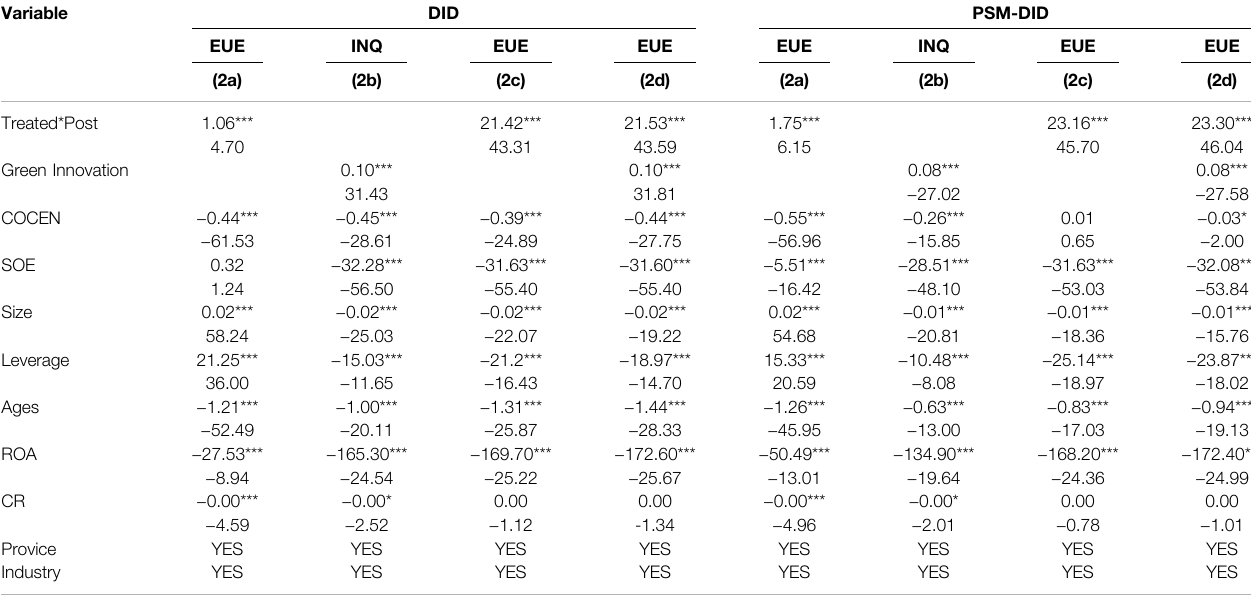
TABLE 14 | OLS robust standard error regression results about regulation by changing the size with Enterprise income. Variable DID PSM-DID EUE INQ EUE EUE EUE INQ EUE